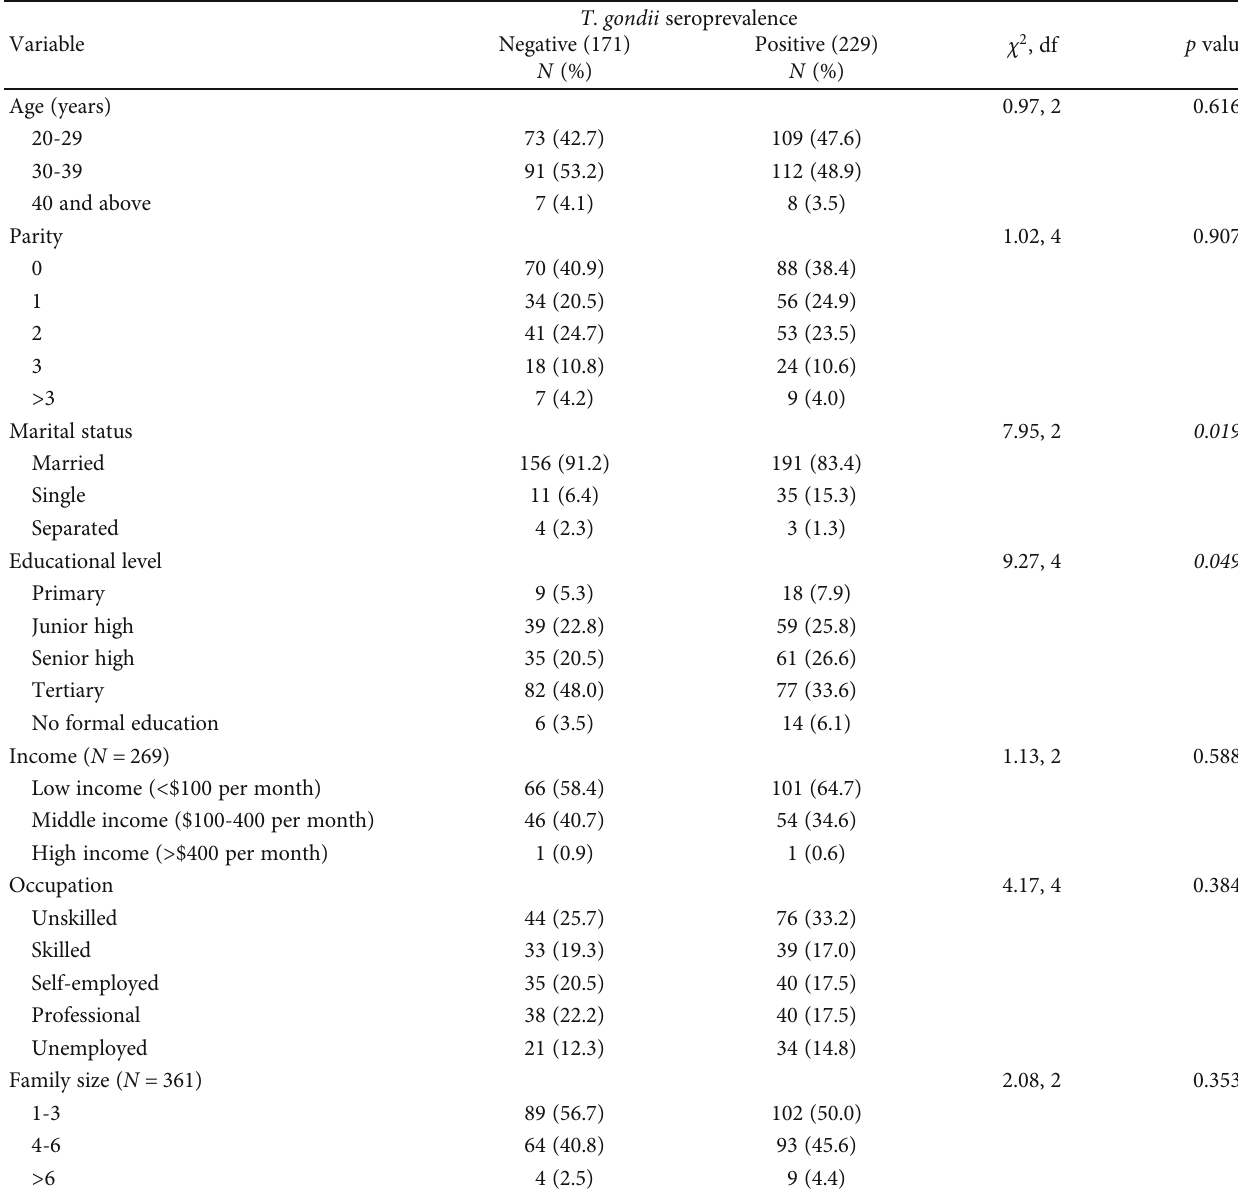
Table 1: Sociodemographic factors and Toxoplasma gondii